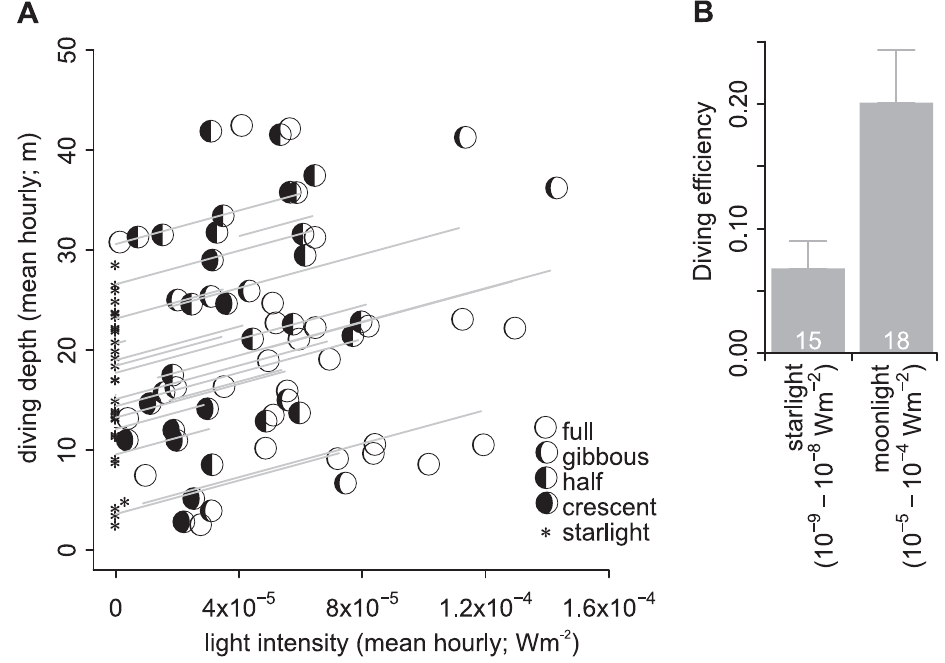
Figure 4. Mean hourly diving depth as a function of mean hourly light intensity (lines are GLMM fitted values by individual) (a) and diving efficiency under a moonlit versus a starlit sky (n indicated) (b).